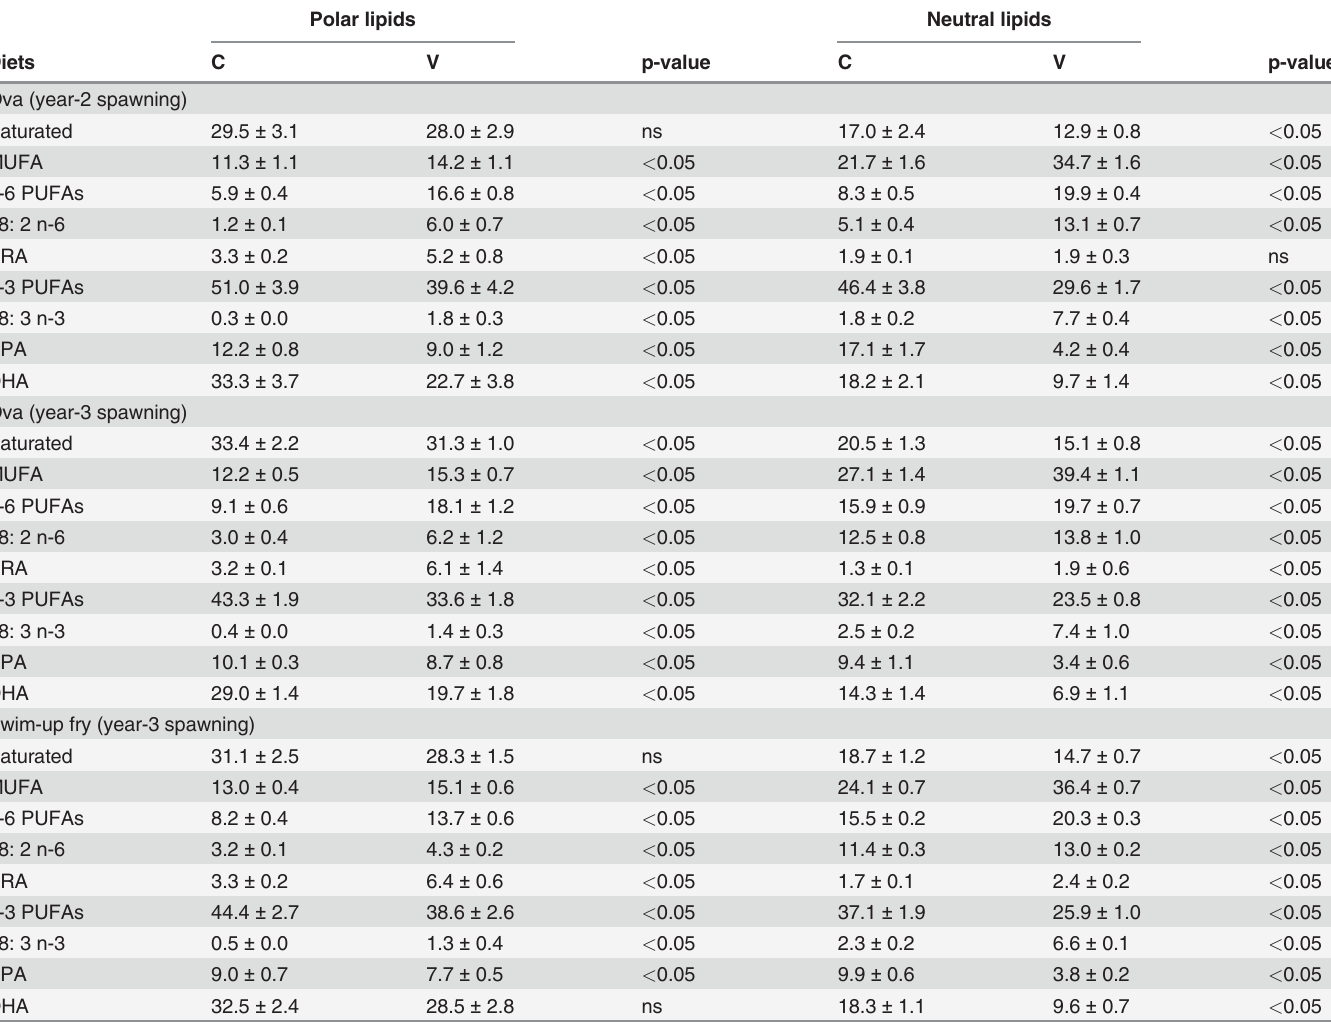
Table 5. Fatty acid composition (% of total FA) of ova and swim-up fry (polar and neutral lipid fractions). Polar lipids Neutral